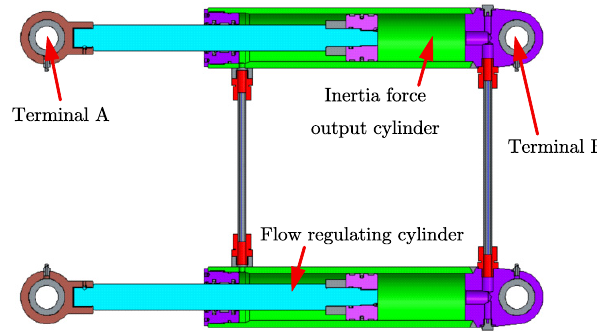
Figure 10. Drawing of the dual-cylinder fluid inerter.